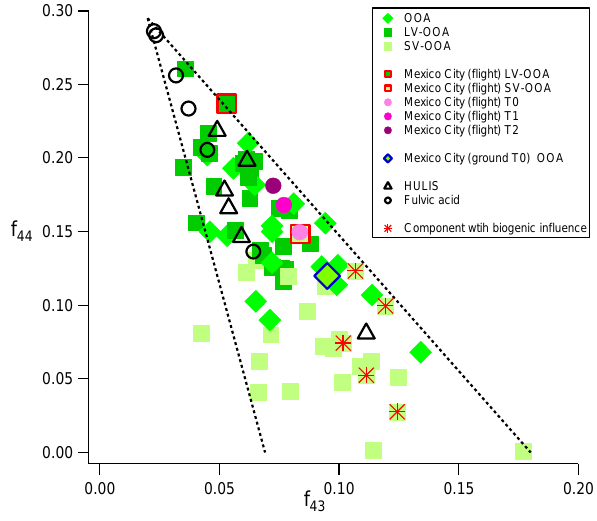
Fig. 4. f 44 vs. f 43 for all the OOA components from different sites, including Mexico city ground and flight data (Aiken et al., 2009b; Jimenez et al., 2009), as well as various HULIS (humic-like substances) and fulvic acid samples. The dotted lines are added to guide the eye and define the triangular space where ambient OOA components fall. The slope and intercept of the line on the left hand side are -6.0204 and 0.4154; the slope and intercept of the line on the right hand side are − 1.8438 and 0.3319, valid for 0.069 ≤ x ≤ 0.18, and y ≤ 0.295. Uncertainties in f 44 and f 43 of these compo- nents are discussed in the